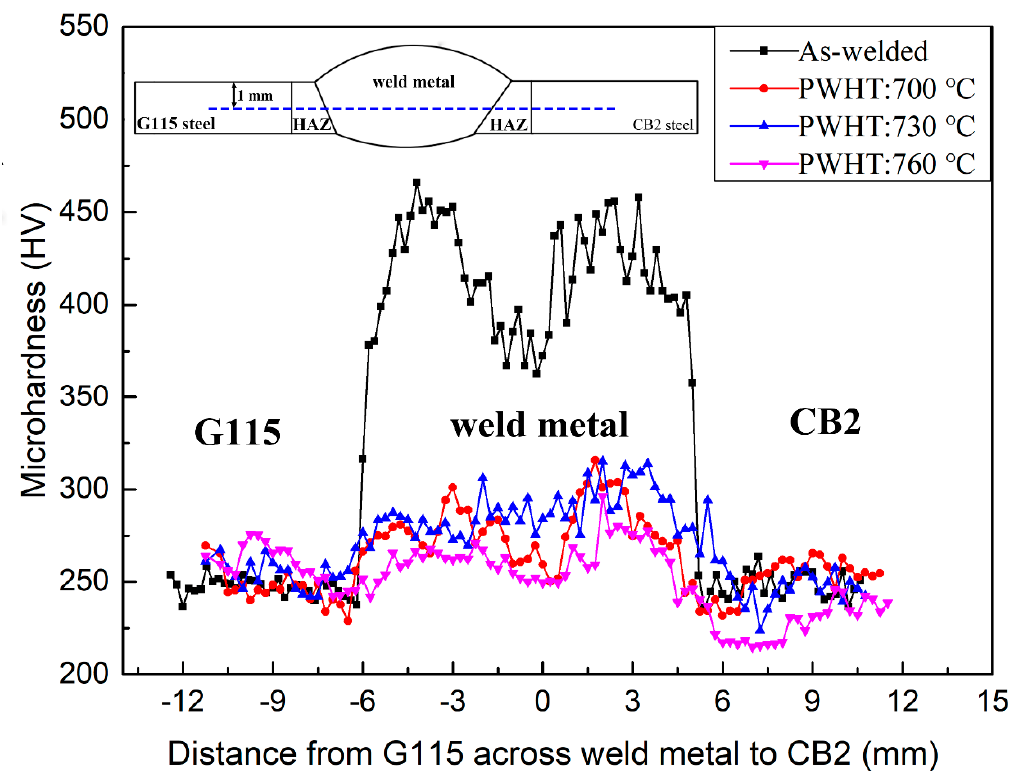
Figure 7. The microhardness profiles of the joint of G115 steel and CB2 steel without and with PWHT.